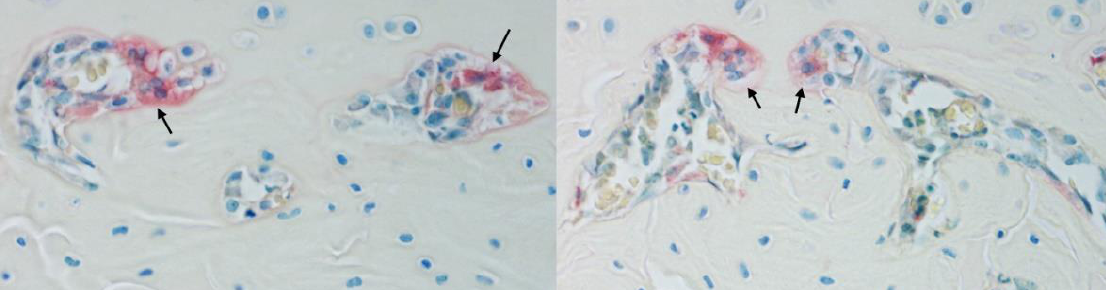
Figure 2. TRAP and toluidine blue staining of a Sprague-Dawley rat tibia, showing osteoclasts with positive TRAP staining (arrows) (female, 10 – 12 weeks of age, original magnification 400×).